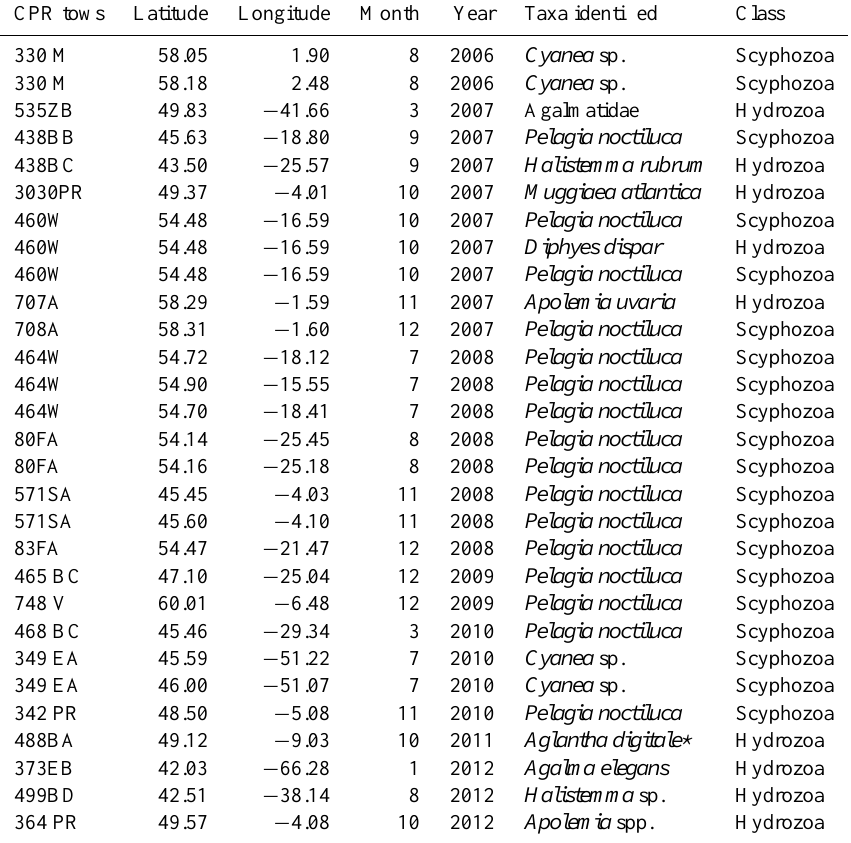
Table 8. Identity of cnidarian tissues collected from CPR samples and identified based upon mt16S rDNA analysis. Sampling information is also indicated. *Sample identified by visual